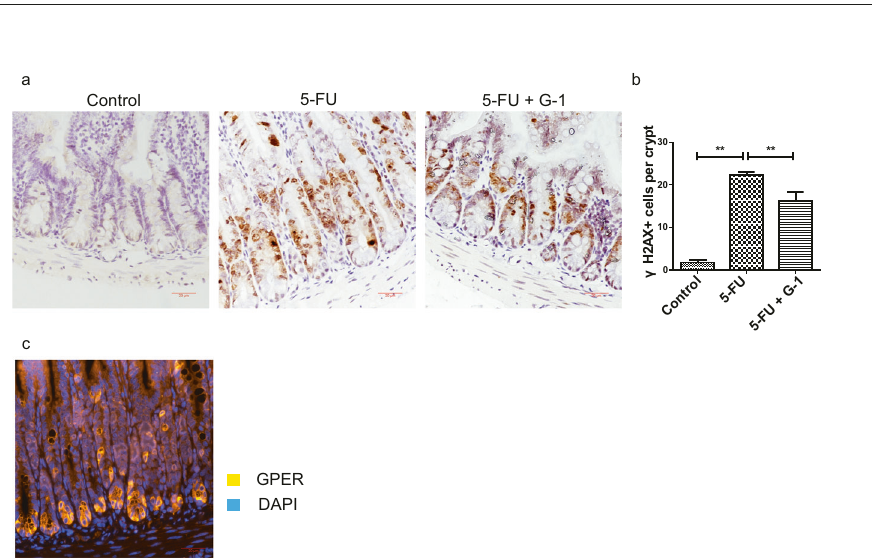
Fig. 4 Effect of GPER activation on crypt cell proliferation in 5-FU induced CIM. CIM model was induced by i.p. injection 5-FU (30 mg/kg/ day) for 5 days. G-1 (0.03 mg/kg/day) and/or G15 (0.3 mg/kg/day) were administrated intraperitoneally with 5-FU together. G-1 was administrated alone or with G15 together in the CIM model to test the effect of GPER activation. On the 5 th day, the ileum was collected for immunohistochemical staining and western blot. Data were expressed as mean ± SEM (* P < 0.05, *** P < 0.001). a Representative images for immunohistochemical staining of BrdU following G-1 administration with or without G15 in the CIM model (scale bars: 20 μ m). b Representative images for immunohistochemical staining of Ki67 following G-1 administration with or without G15 in the CIM model (scale bars: 20 μ m). c Statistical graph for the number of BrdU + cells per crypt within four subgroups to show the effect of GPER activation on proliferation of crypt cells in the CIM model. At least 20 crypts were counted randomly for each sample, and the mean value was calculated for single sample ( n = 6). d Statistical graph for the number of Ki67 + cells per crypt within four subgroups to show the effect of GPER activation on proliferation of crypt cells in the CIM model. At least 20 crypts were counted randomly for each sample, and the mean value was calculated for single sample ( n = 6). e Statistical graph of villous height following G-1 administration with or without G15 in the CIM model. At least 20 villi were counted randomly for each sample, and the mean value was calculated for single sample ( n = 10). f Statistical graph of crypt depth following G-1 administration with or without G15 in the CIM model. At least 20 crypts were counted randomly for each sample, and the mean value was calculated for single sample ( n = 10). g Representative western blots photograph to show the effect of G-1 administration with or without G15 on cyclin D1 and cyclin B1 expression in the CIM model. h Statistical analysis of cyclin D1 and cyclin B1expression within four subgroups to show the effect of GPER activation on cyclin D1 and cyclin B1 expression in the CIM model ( n = 5).